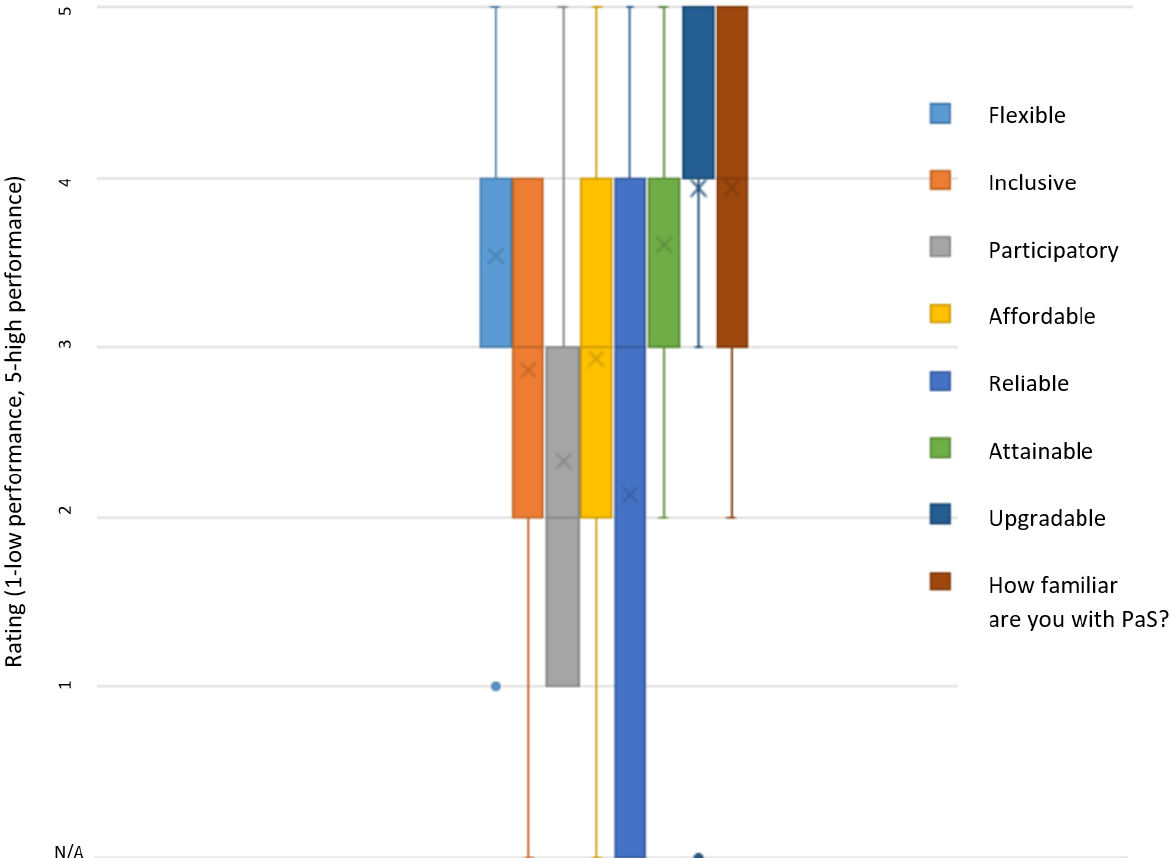
Figure 10. Assessment of PaS against the FFP elements and familiarity with the platform.